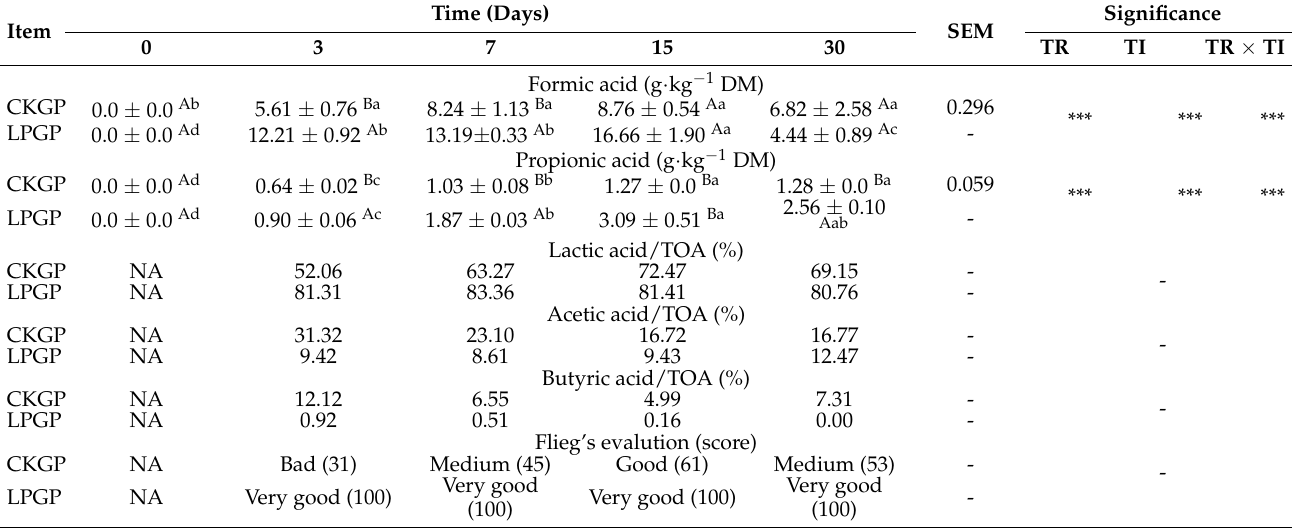
Table 4. Ensiling quality evaluated by Flieg’s score based on the concentration of organic